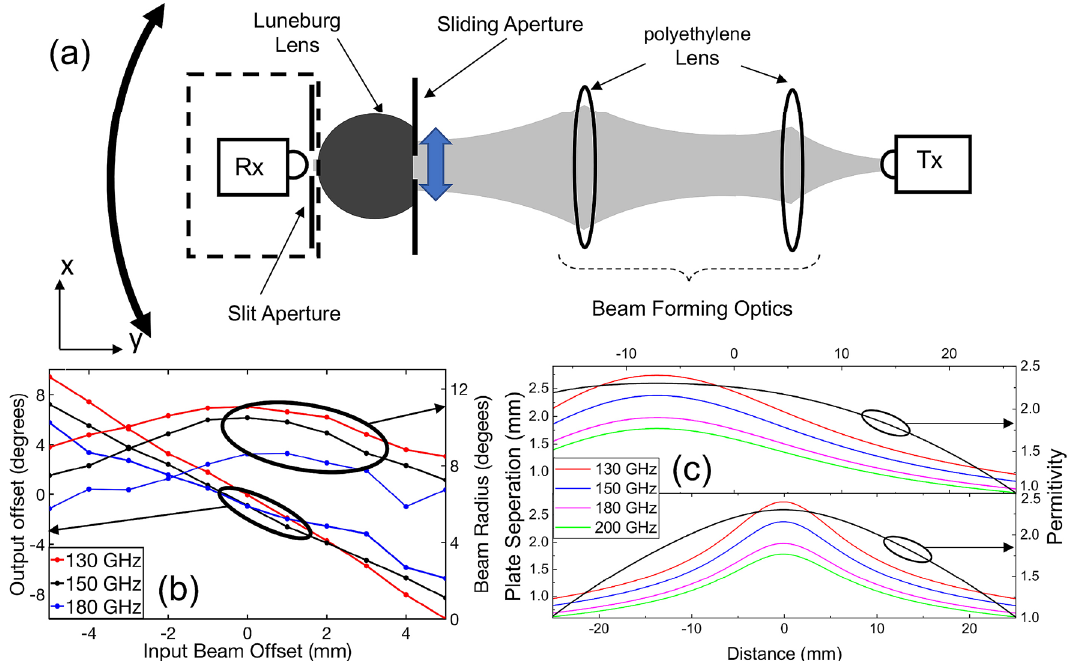
Figure 3. ( a ) Experimental setup for beam steering application. ( b ) Measured beam offset of the output beam and its radius as a function of the input beam offset. ( c ) The plate separation and the permittivity profiles of an ideal device, at several different frequencies, along two different cross-sections indicated by dashed lines in Fig. 1b. These are computed using Eq. (3). In these figures, the black solid curves give the desired permittivity profiles along the same two